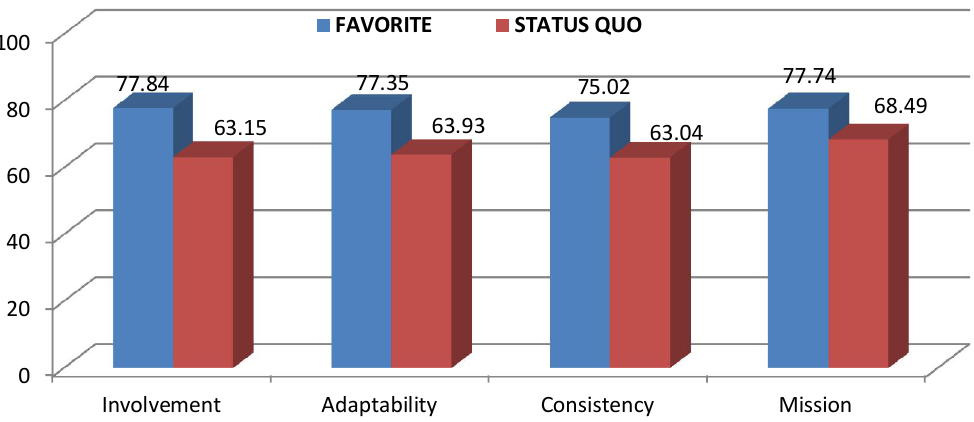
Fig. 6. Comparing Status Quo Trait Scores with Favorite Organizational Culture Using Top Manager’s